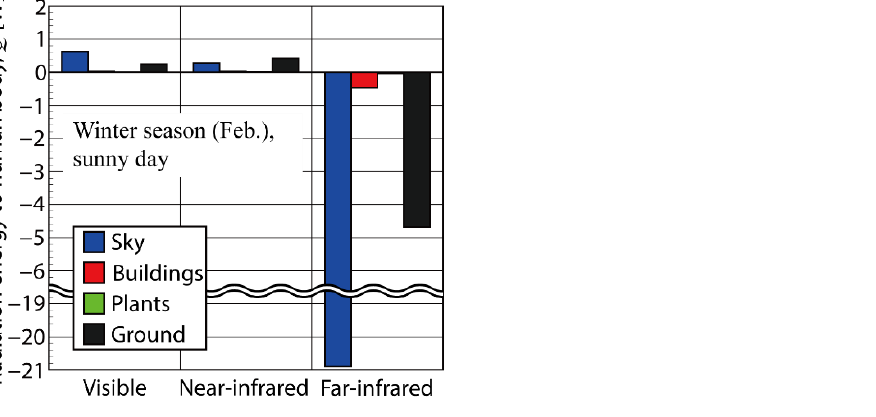
Figure 12. Calculated radiation energy to human body in winter experiment at the Imperial Palace.